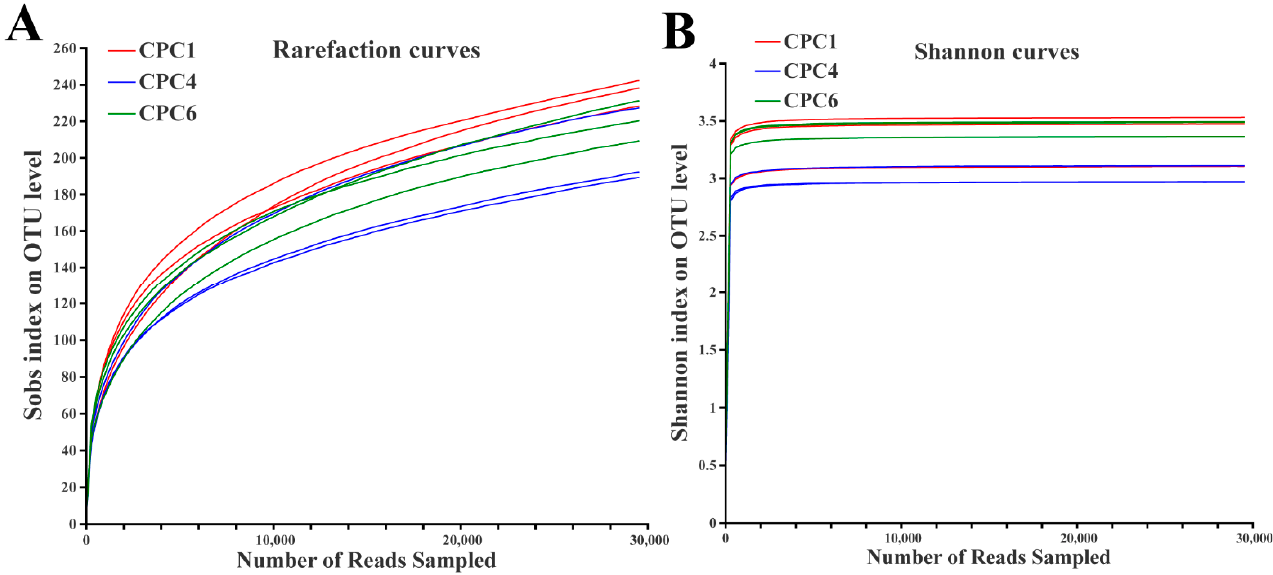
Figure 7. Rarefaction curves ( A ) and Shannon curves ( B ) of the OTUs clustered at a 97% phylotype similarity level of the fish intestinal microbiota from the different dietary protein treatments. The horizontal axis is the number of valid sequences; the vertical axis is the observed number of operational taxonomic units. The Sobs index and Shannon index were used to estimate the richness and diversity of the intestinal microbiota, respectively.